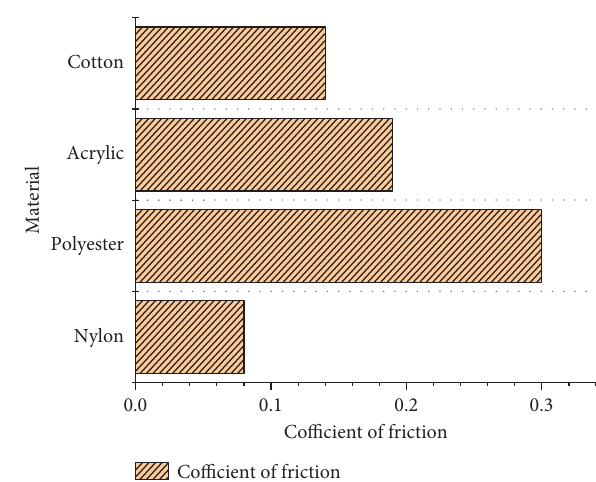
Figure 12: Coefcient of friction of